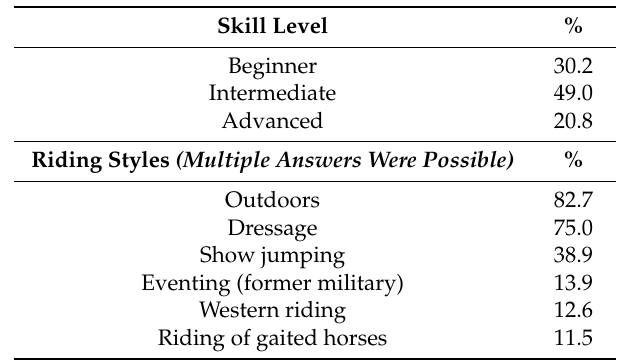
Table 1. Skill level and riding